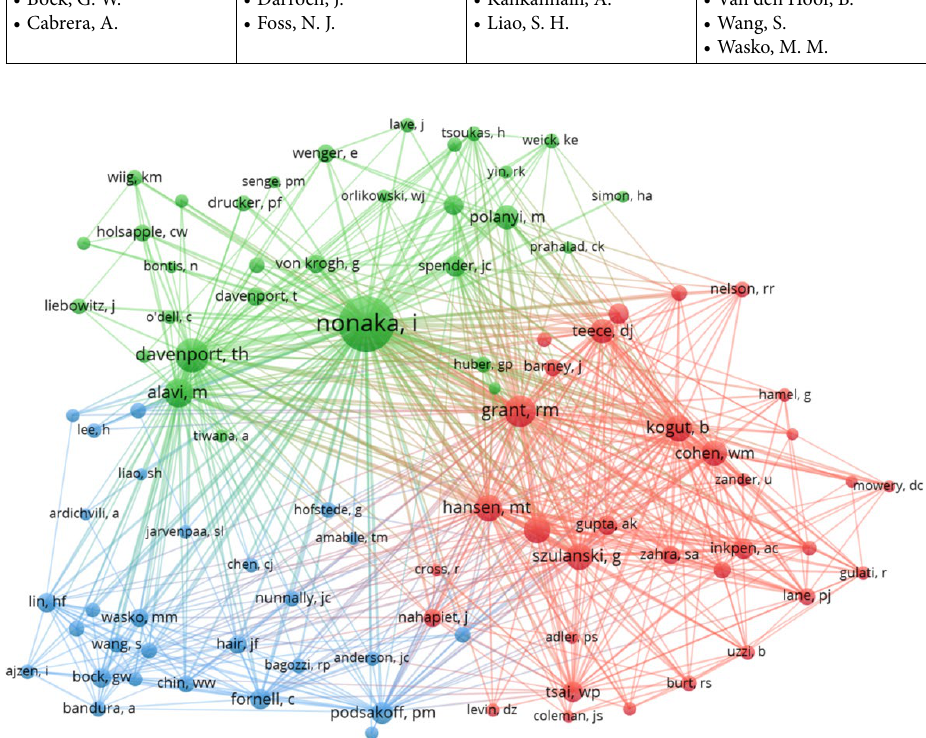
Figure 5. Authors’ co-citation